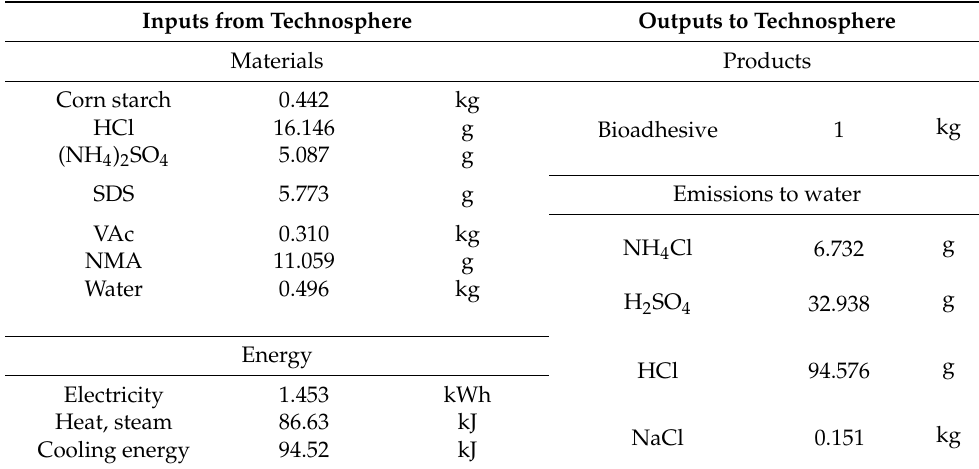
Table 2. Inventory data for the production of hydrolyzed starch bioadhesive with N-methylol acrylamide (NMA) (Alternative 2). Detailed data per functional unit (1 kg of bioadhesive). Acronyms: